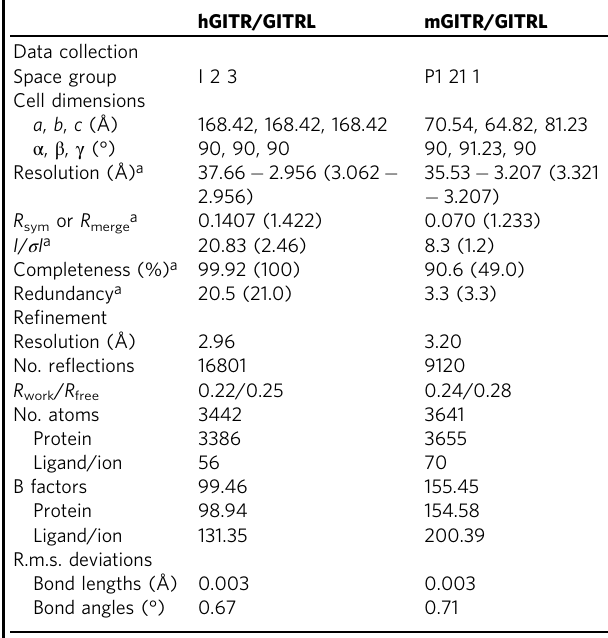
Table 1 Data collection and re fi nement statistics (molecular